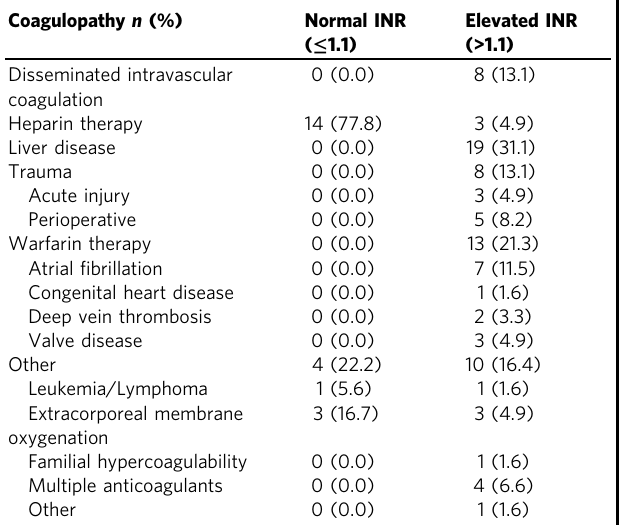
Table 1 Coagulopathies of